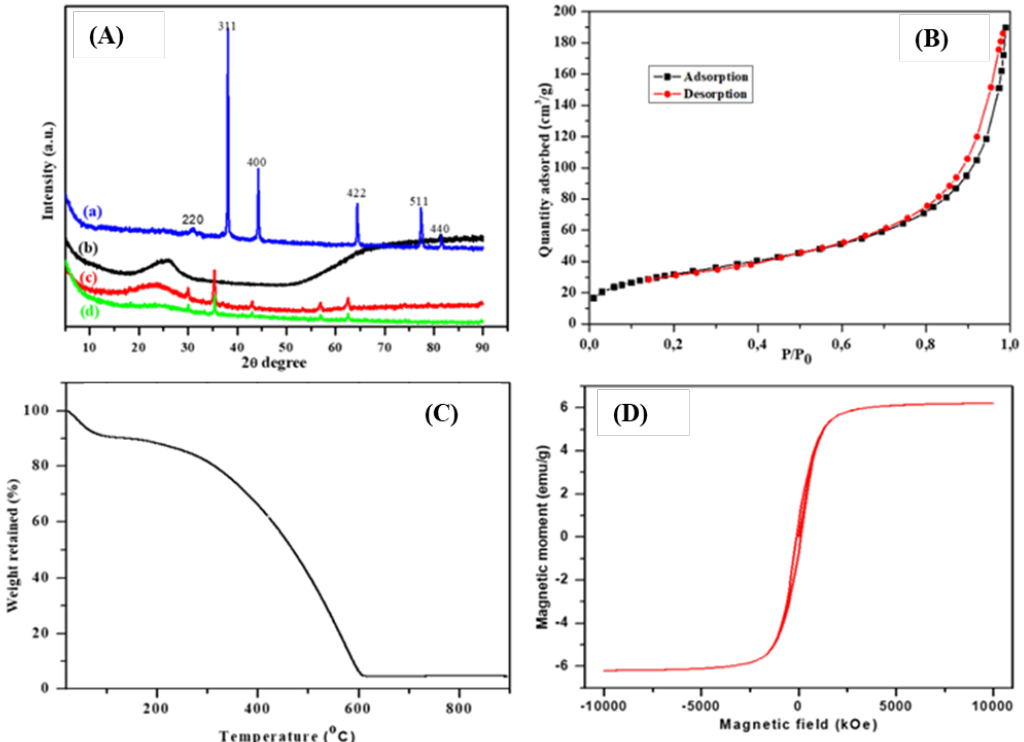
Figure 4. X-ray diffraction (XRD) patterns ( A ) of ( a ) Fe 3 O 4 nanoparticles, ( b ) PPy and PPy– m PD/Fe 3 O 4 nanocomposite before ( c ) and after ( d ) Cr(VI) adsorption. Brunauer–Emmet–Teller (BET) spectrum ( B ), thermogravimetric analysis (TGA) thermogram ( C ) and vibrating sample magnetometer (VSM) plot ( D ) of the PPy– m PD/Fe 3 O 4 nanocomposite.